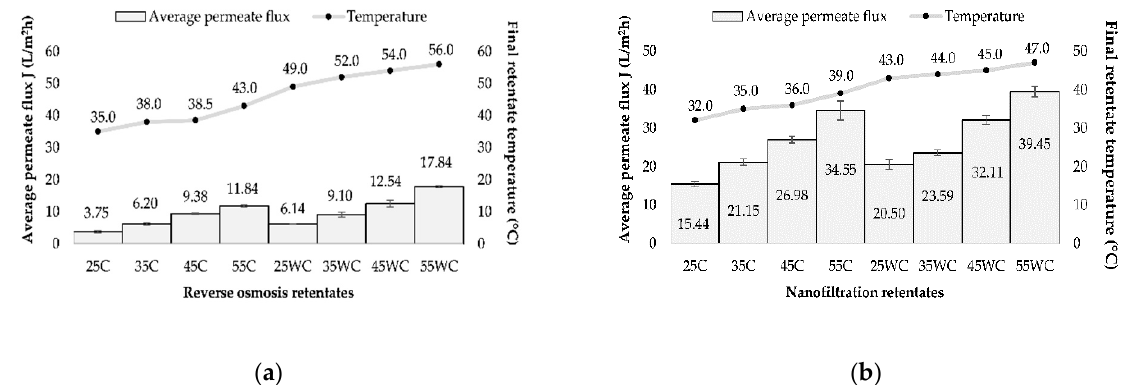
Figure 1. Influence of transmembrane pressure (25, 35, 45, and 55 bar) on the average permeate flux (L/m 2 h) and retentate temperature (°C) during concentration of Cabernet Sauvignon red wine by reverse osmosis ( a ) and nanofiltration ( b ), with (C) and without cooling (WC).